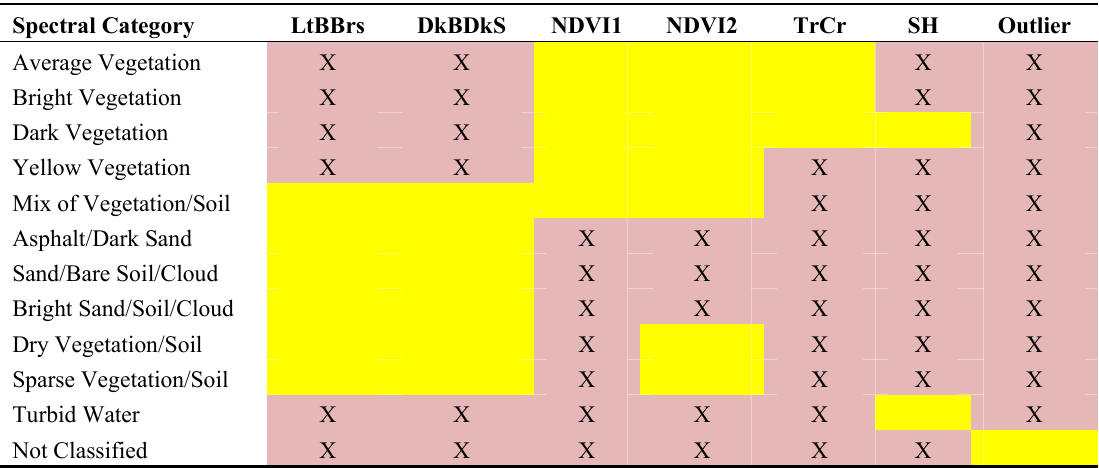
Table 12. ATCOR™-SPECL pre-classification of the Leica test image. OAMTRX instance between test classes (refer to Table 2) and reference classes (refer to Table 7), represented as table rows and columns respectively. For the sake of simplicity, only test classes (table rows) whose occurrence is greater than 0.15% in the test map being investigated are shown. “Correct” entries selected by the present authors for inter-vocabulary reconciliation are shown as yellow